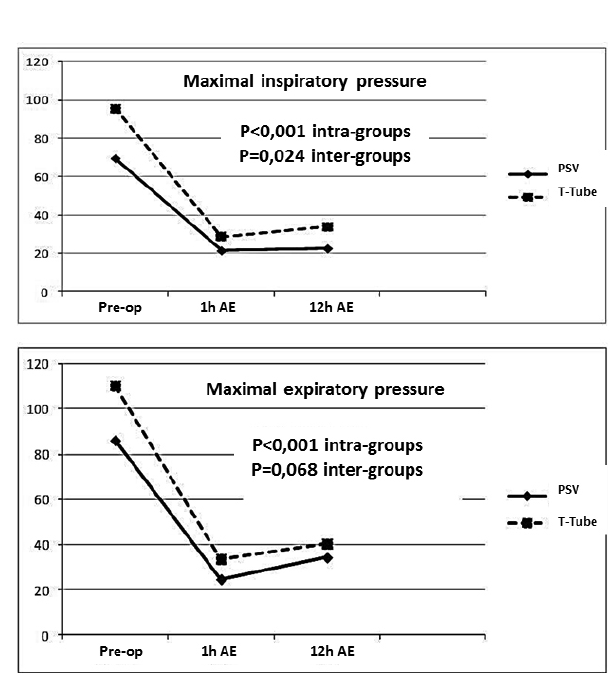
Fig. 2 - Perioperative evolution of the maximal inspiratory and